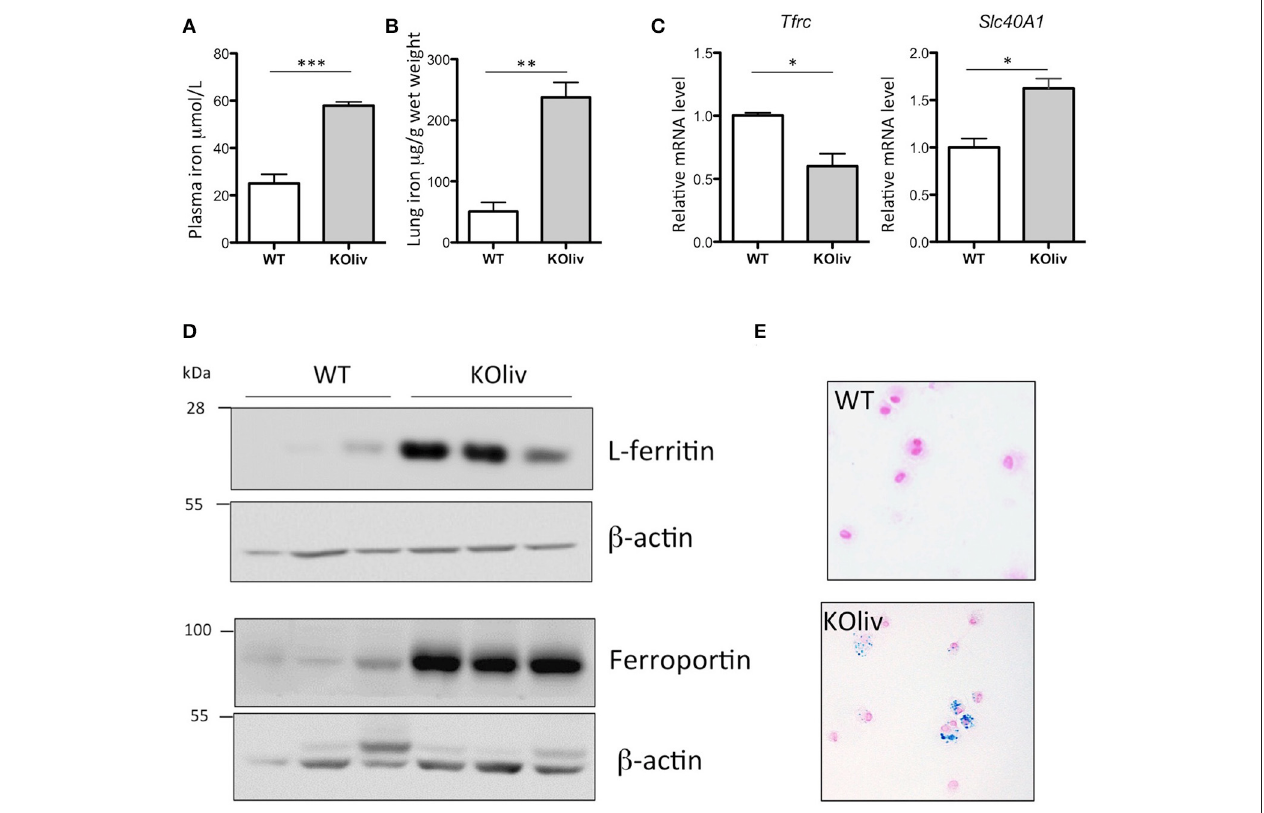
FIGURE 5 | Iron load phenotype in the lung of WT and Hepc KOliv mice: Plasma iron in µ M (A) and lung iron in µ g/g wet tissue (B) . Pulmonary Tfrc , and Slc40A1 mRNA levels relative to Ppia analyzed by real-time PCR. Changes are expressed relative to WT mice (C) . L-ferritin and ferroportin (D) protein levels analyzed by WB using proteins from cytosolic and membrane enriched-fractions, respectively. Representative images of BAL (bronchoalveolar lavages) cytospin slides obtained from WT and Hepc KOliv mice and stained with Perls’ Prussian blue (E) .The set of results obtained with WT and Hepc KOliv mice were reproduced using another serie of animals. Error bars represent SEM for n = 3–4 mice in each group. Statistical significance is indicated by asterisks (* p < 0.05, ** p < 0.01, *** p <